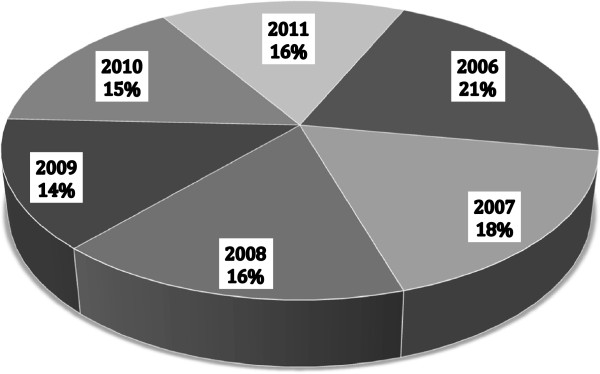
Annual incidence of 778 patients with CSDH.